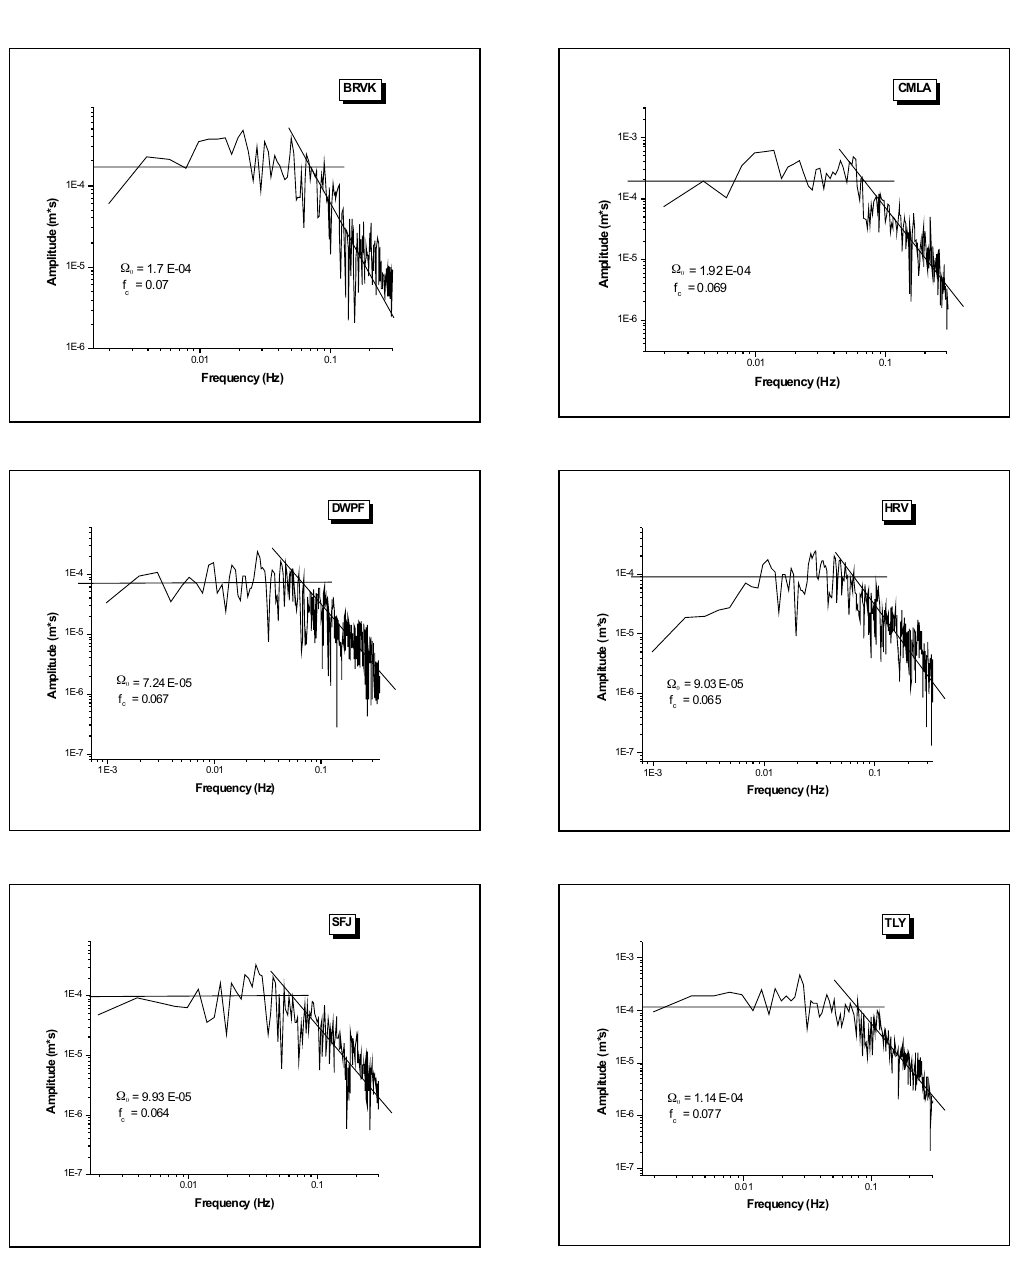
Fig. 6. Far-field amplitude displacement spectra used to estimate the fault dimensions and other parameters of the Skyros mainshock. The low and high frequency asymptotes (fitted by eye) are depicted as straight lines. The corresponding values of the low-frequency part of the spectrum, (cid:49) for each